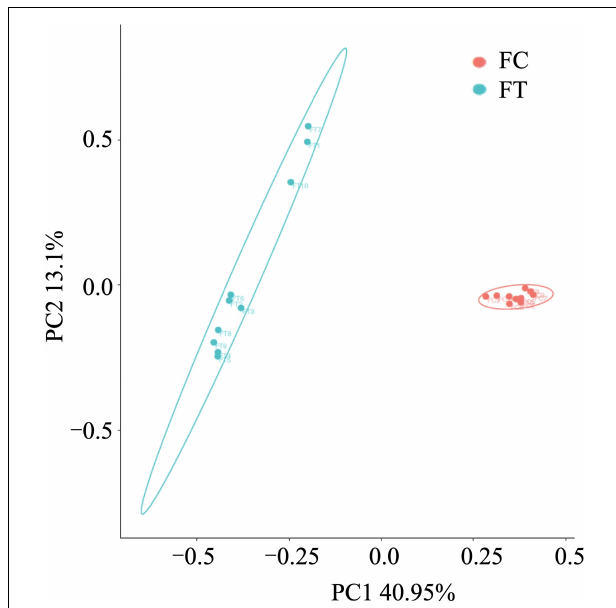
FIGURE 2 | Principal-coordinates analysis (PCoA) based on Bray-Curtis dissimilarities of the gut microbiota in the control females (FC) and the antibiotic-treated females